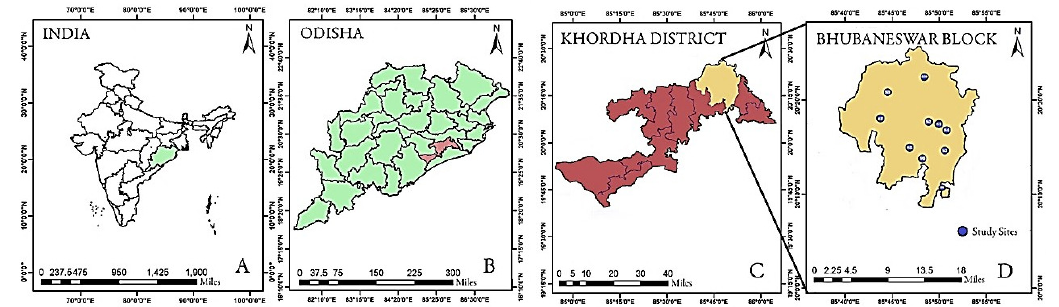
Figure 1. Map of Study Area: A. India, B. Odisha State, C. Khordha District, D. Bhubaneswar Block with site locations